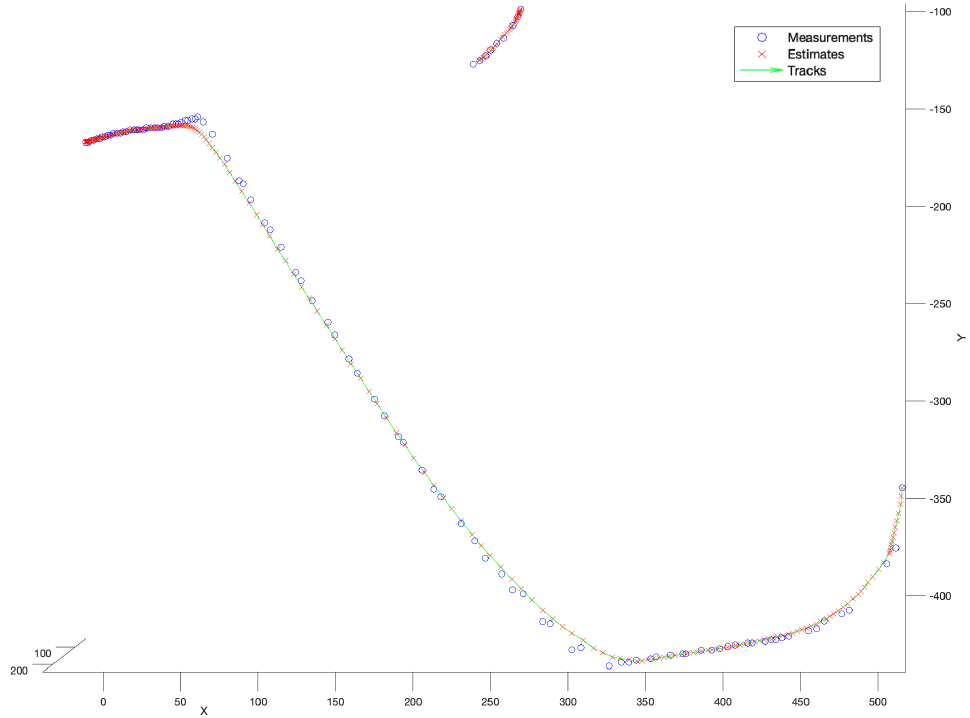
Figure 7. Performance of no-model tracker. Multiple bird flight